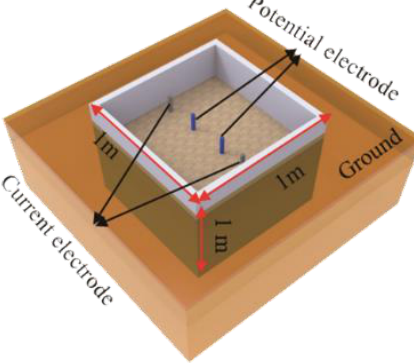
Figure 4. Experiment in outdoor laboratory tank.